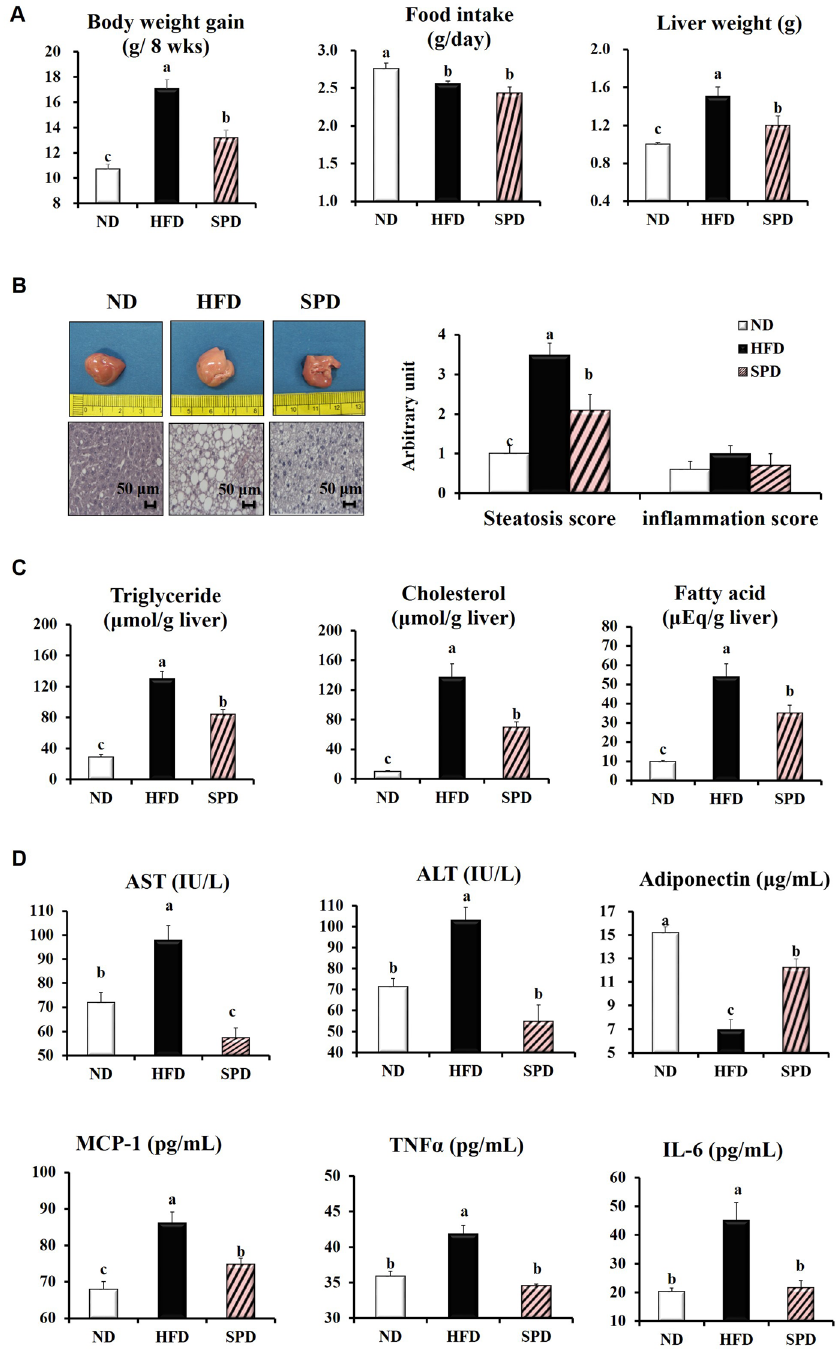
Figure 3. Scopolin alleviates hepatic steatosis in HFD-fed mice. C57BL/6 N mice were fed a ND, HFD, and SPD for 8 weeks. ( A ) Changes in body weight, food intake, and liver weight. ( B ) Representative pictures of livers and H&E staining for liver (scale bar = 50 μ m), and hepatic steatosis and inflammation scores. ( C ) Hepatic TG, cholesterol, and fatty acid concentrations. ( D ) Plasma AST and ALT activities and plasma adiponectin, MCP- 1, TNF α , and IL-6 levels. Data shown are means ± SEM (n = 8). Bars with different letters differ significantly (p <